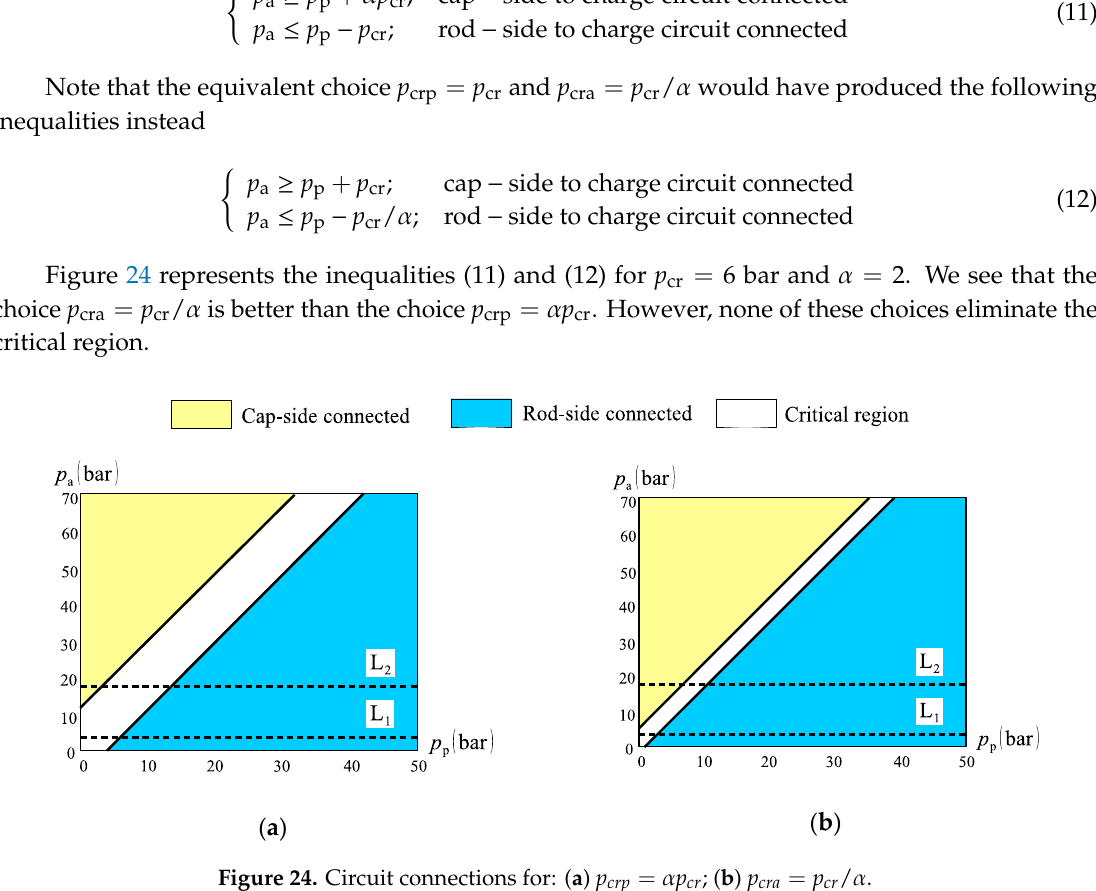
Figure 24. Circuit connections for: ( a ) p crp = α p cr ; ( b ) p cra = p cr / α .